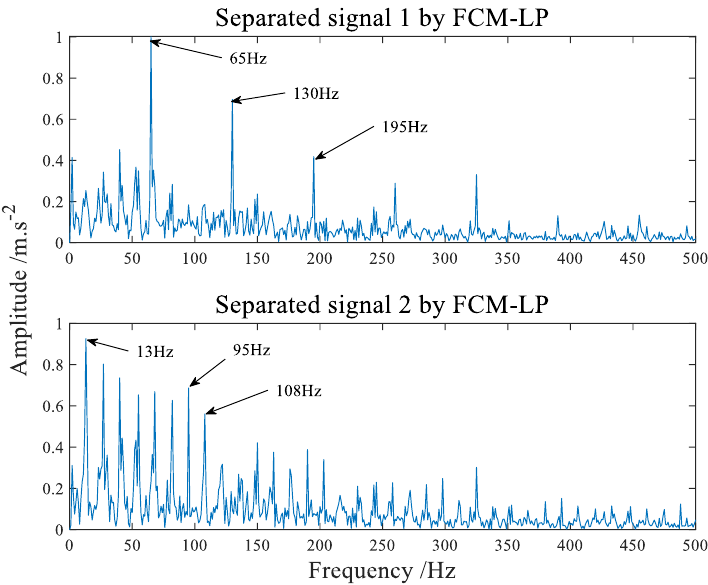
Figure 17. The frequency domain spectrum of separated signal processed by FCM − LP.